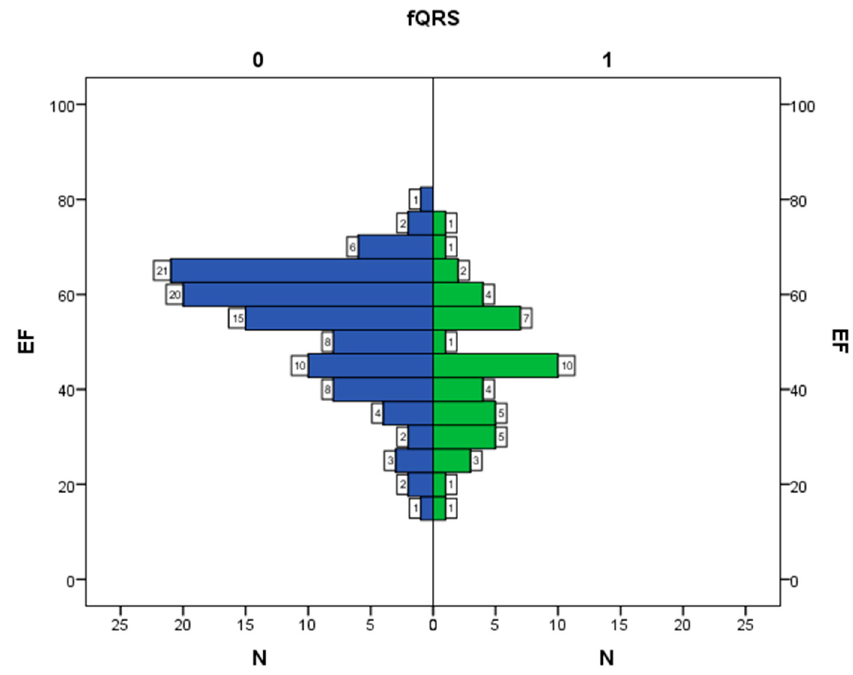
Figure 3. Interrelation between ejection fraction and fQRS; N—number of observations, EF—ejection fraction, fQRS—fragmented QRS complex, 0—there is no fragmented QRS complex, 1—there is fragmented QRS complex.